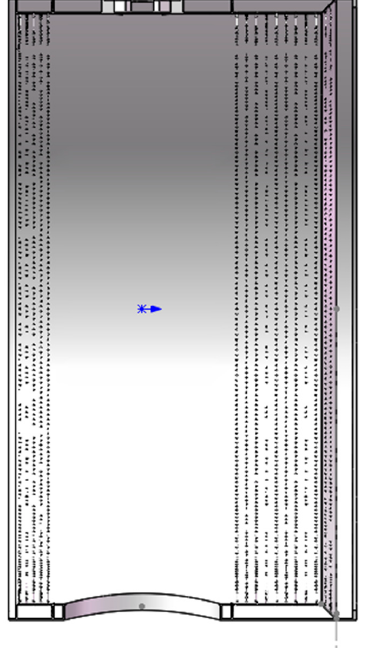
Figure 10. Distribution of the intake holes.